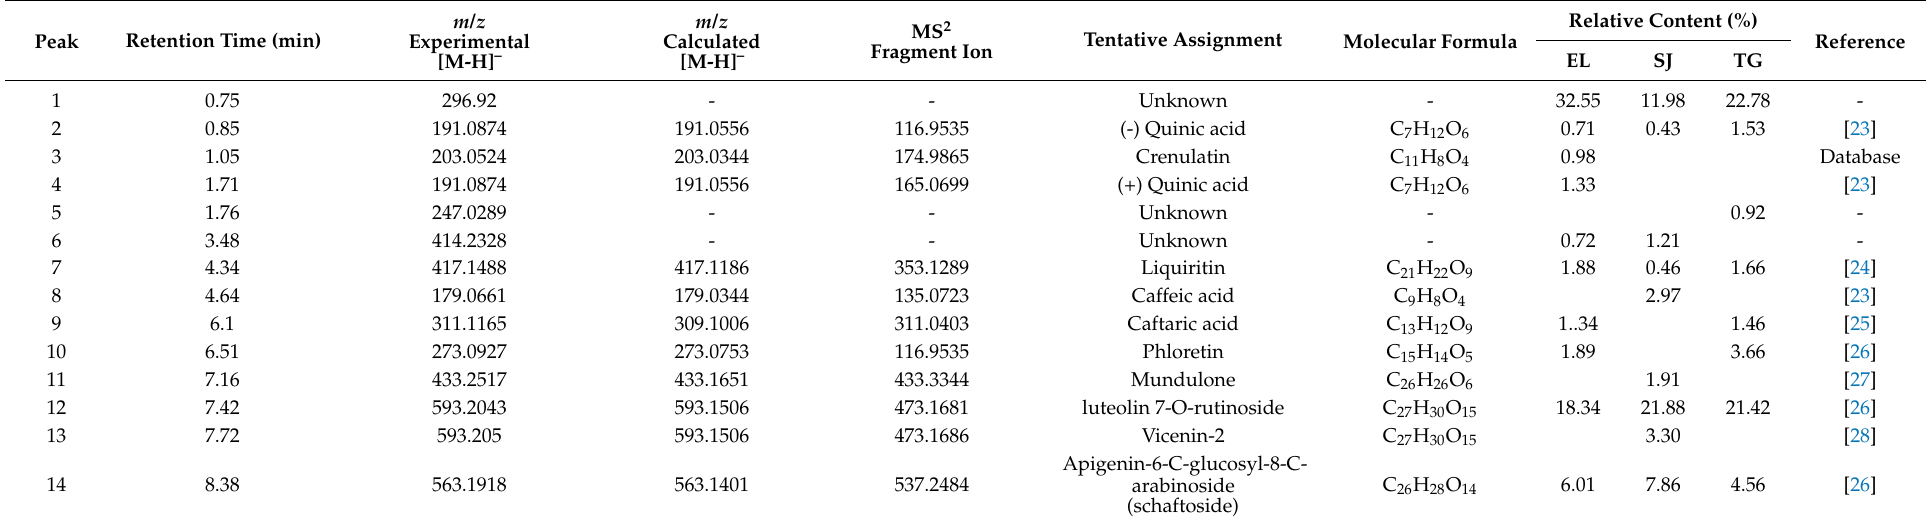
Table 4. Identification of polyphenolic compounds of F. cernua by UPLC/QToF-M 2